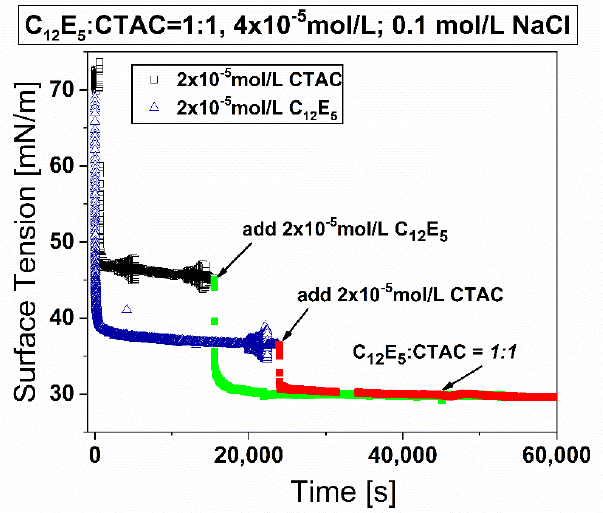
Figure 11. Dynamic surface tension of a single component and consecutive addition of second component. The total surfactant concentration is 4.0 × 10 − 5 mol / L for mol:mol ratio of 1:1 mixture CTAC and C 12 E 5